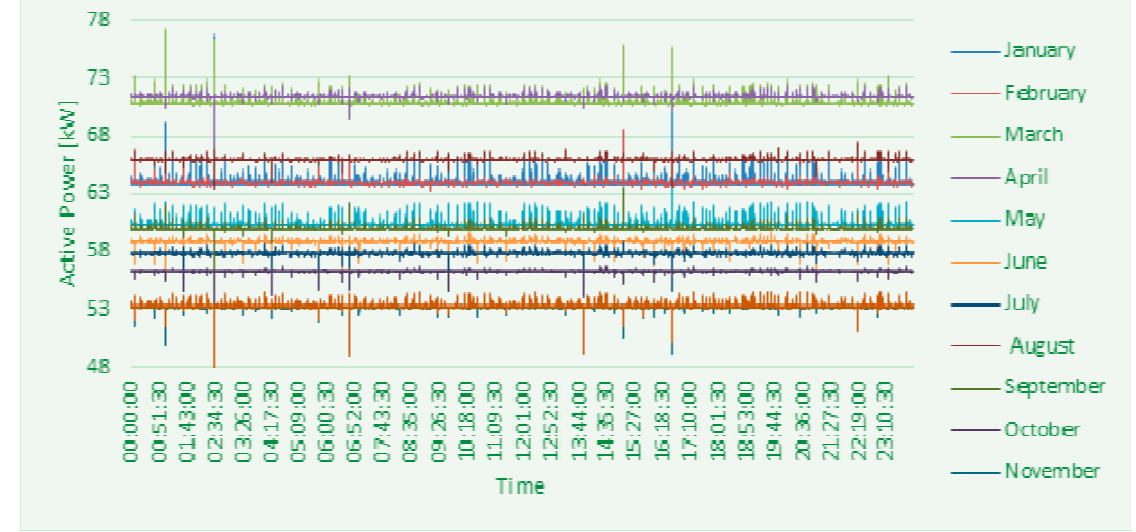
Figure 4. Average daily energy consumption for each month of 2016.